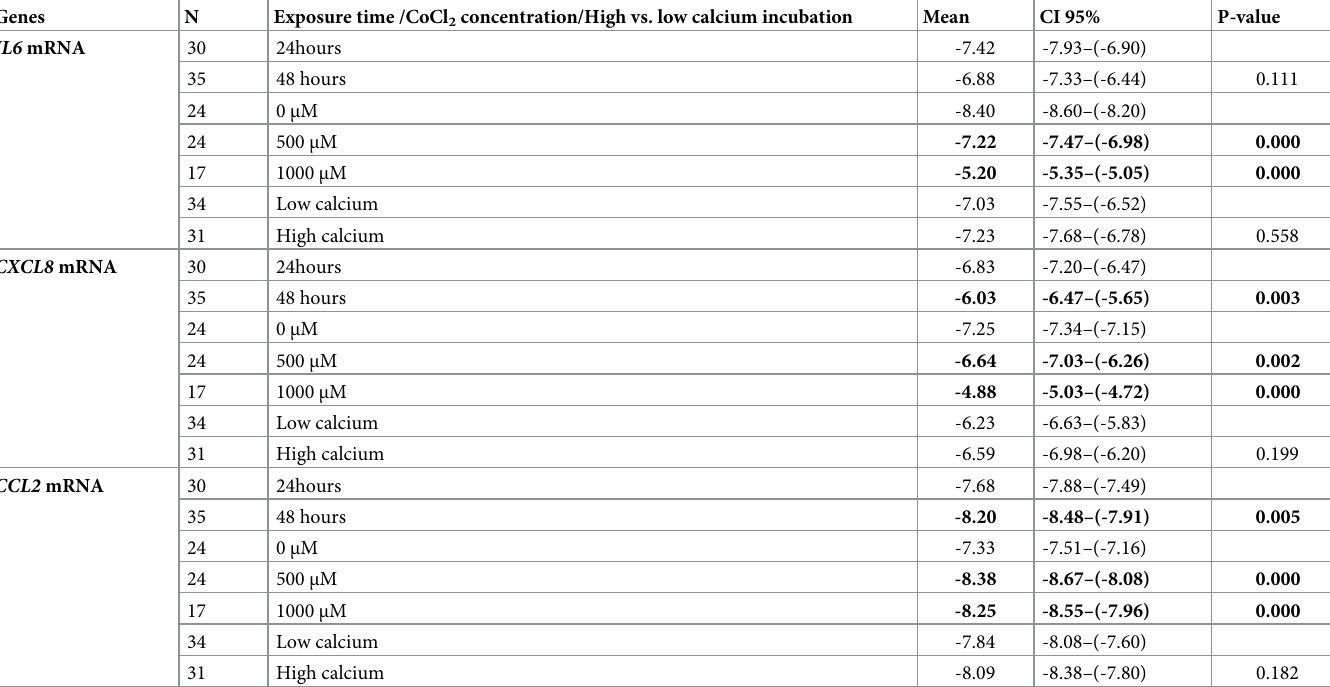
Table 3. ANOVA analyses showing dose- and time-relationships for the relative levels of IL6 mRNA, CXCL8 mRNA and CCL2